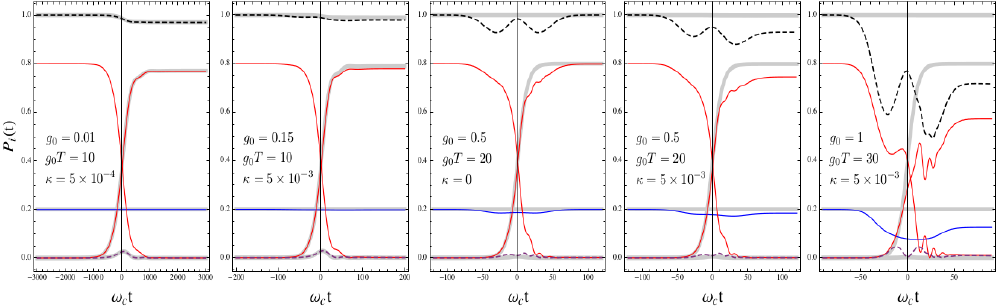
Figure 2. Population transfer by STIRAP in RWA and USC, at the doubly resonant point ω c = (cid:101) i , √ √ for initial state | ψ 0 (cid:105) = 0.2 | 0 gg (cid:105) + i 0.8 | 0 ge (cid:105) and τ = 0.7 T . Colors: blue ( P | 0 gg (cid:105) ), red ( P | 0 ge (cid:105) and P | 0 eg (cid:105) ), magenta dashed ( P | 1 gg (cid:105) ), black dashed (sum of the above populations, i.e., the STIRAP subspace), thick gray (RWA). Parameters are in units of ω c . Counterrotating terms do not modify the RWA behavior up to g 0 ∼ 0.15 ω c , which is a nearly optimal value for minimizing T ; notice that a larger κ = 0.005 is used. At stronger coupling adiabaticity requires a less favorable scaling of T , and leakage from the STIRAP subspace occurs; this leakage is reversible for κ = 0 (due to the symmetries of the Hamiltonian) but becomes detrimental for finite κ